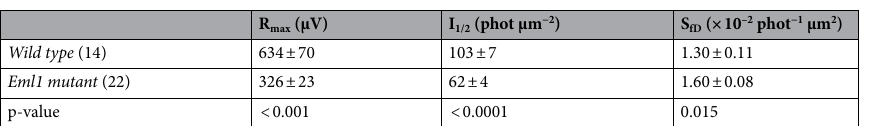
Table 1. Rod ex-vivo ERG analysis parameters. R max , saturated response amplitude measured at the plateau. I 1/2 , intensity required to produce half of the saturated response. S fD , dark-adapted sensitivity. All values are given as Mean ± S.E.M.